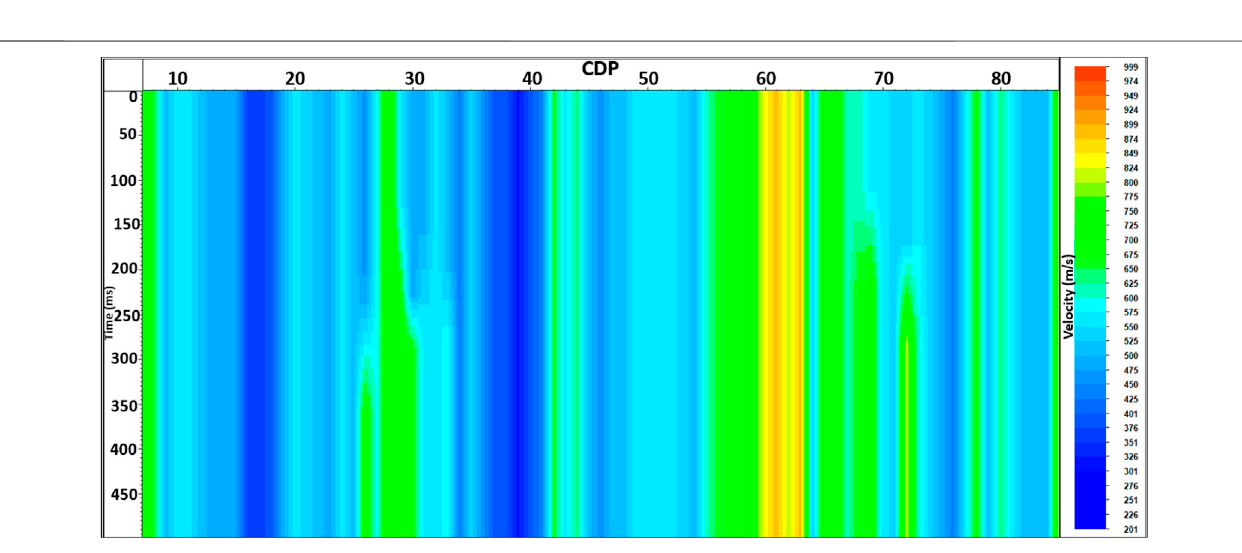
Frontiers in Earth Science |